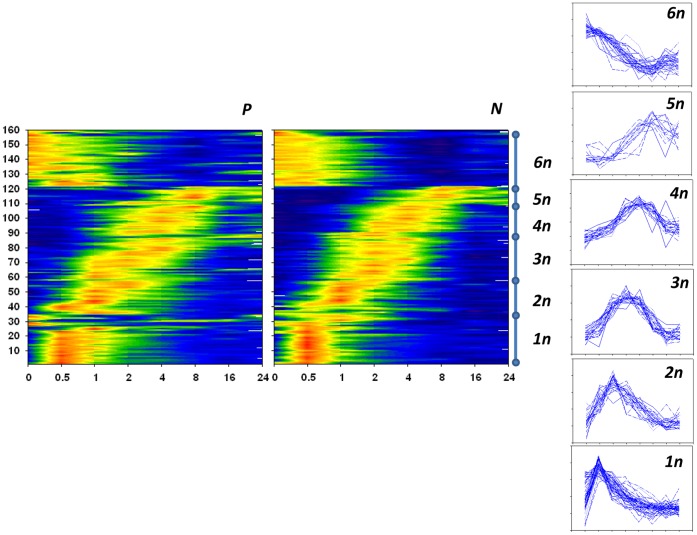
Variable gene clustering after stimulation of B cells from lupus patients and controls.Normalized gene expression data (average = 0, standard deviation = 1) from stimulated hyperresponsive B cells from SLE patients (left) and normal response B cells from control (right). Blue indicates negative normalized expression data and red indicates positive normalized expression data. Six gene clusters and the corresponding cluster profiles are shown to the right side of the heat-maps.